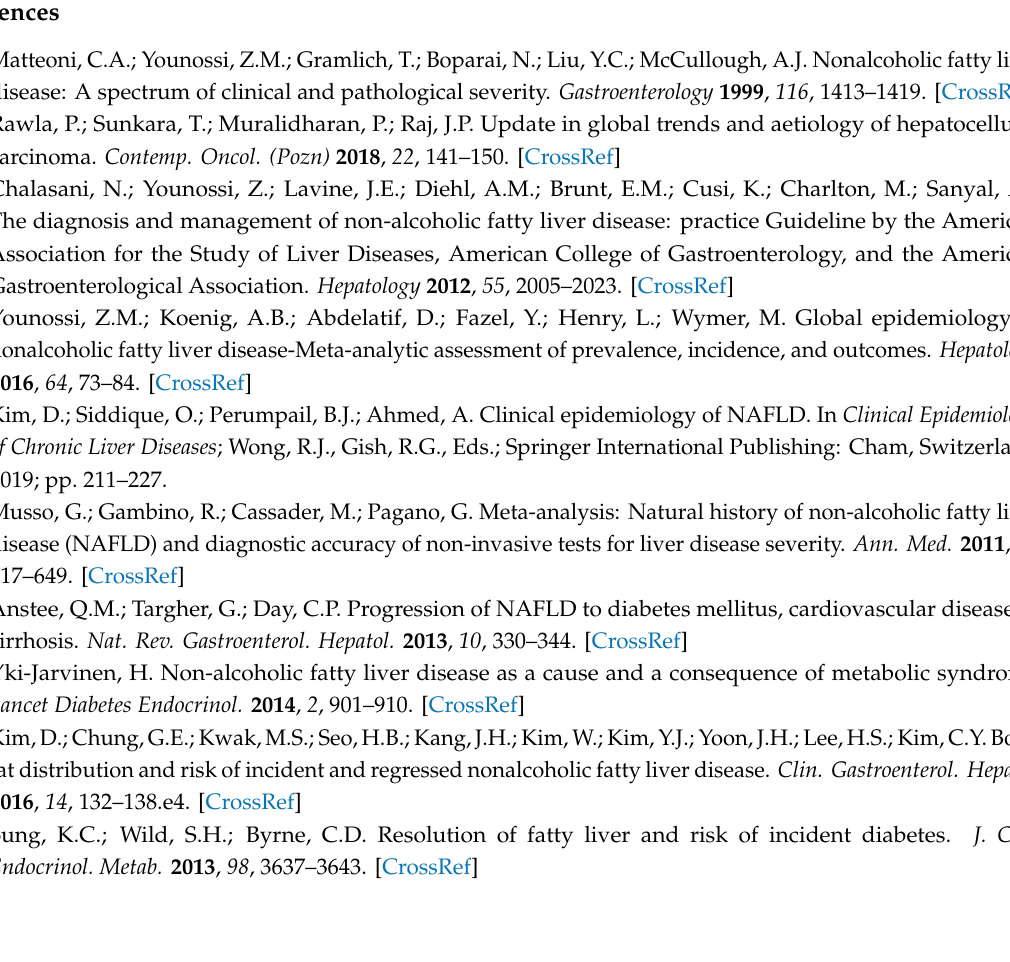
Figure S1: Beta diversity analysis between the G0 and G3 groups. (A) Weighted UniFrac and (B) Bray–Curtis PCoA plots of individual sample in each group; Table S1: Comparisons of the alpha diversity between fatty liver groups in pairwise Kruskal–Wallis test; Table S2: Beta diversity between fatty liver groups in pairwise PERMANOVA; Table S3: Predicted functional microbiota for fatty liver persistence using